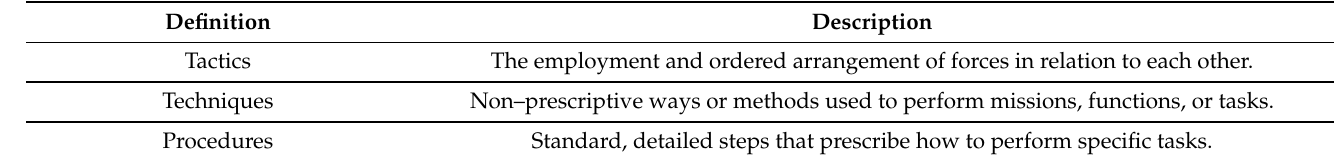
Table 1. Tactics, Techniques, and Procedures (TTP)